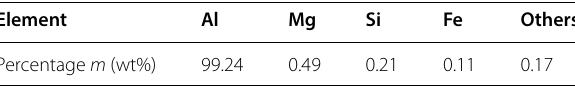
Table 2 The elementary composition of the 6063 Al alloy workpiece